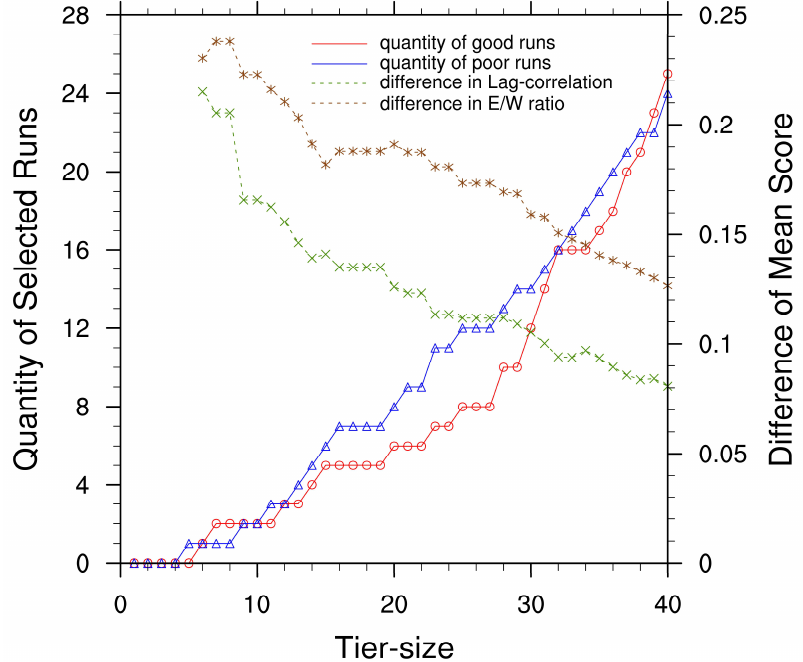
Figure 4. Quantities of selected good and poor simulations (left y-axis) and differences between mean scores of selected good and poor simulations (right y-axis) according to different values of tier-size.